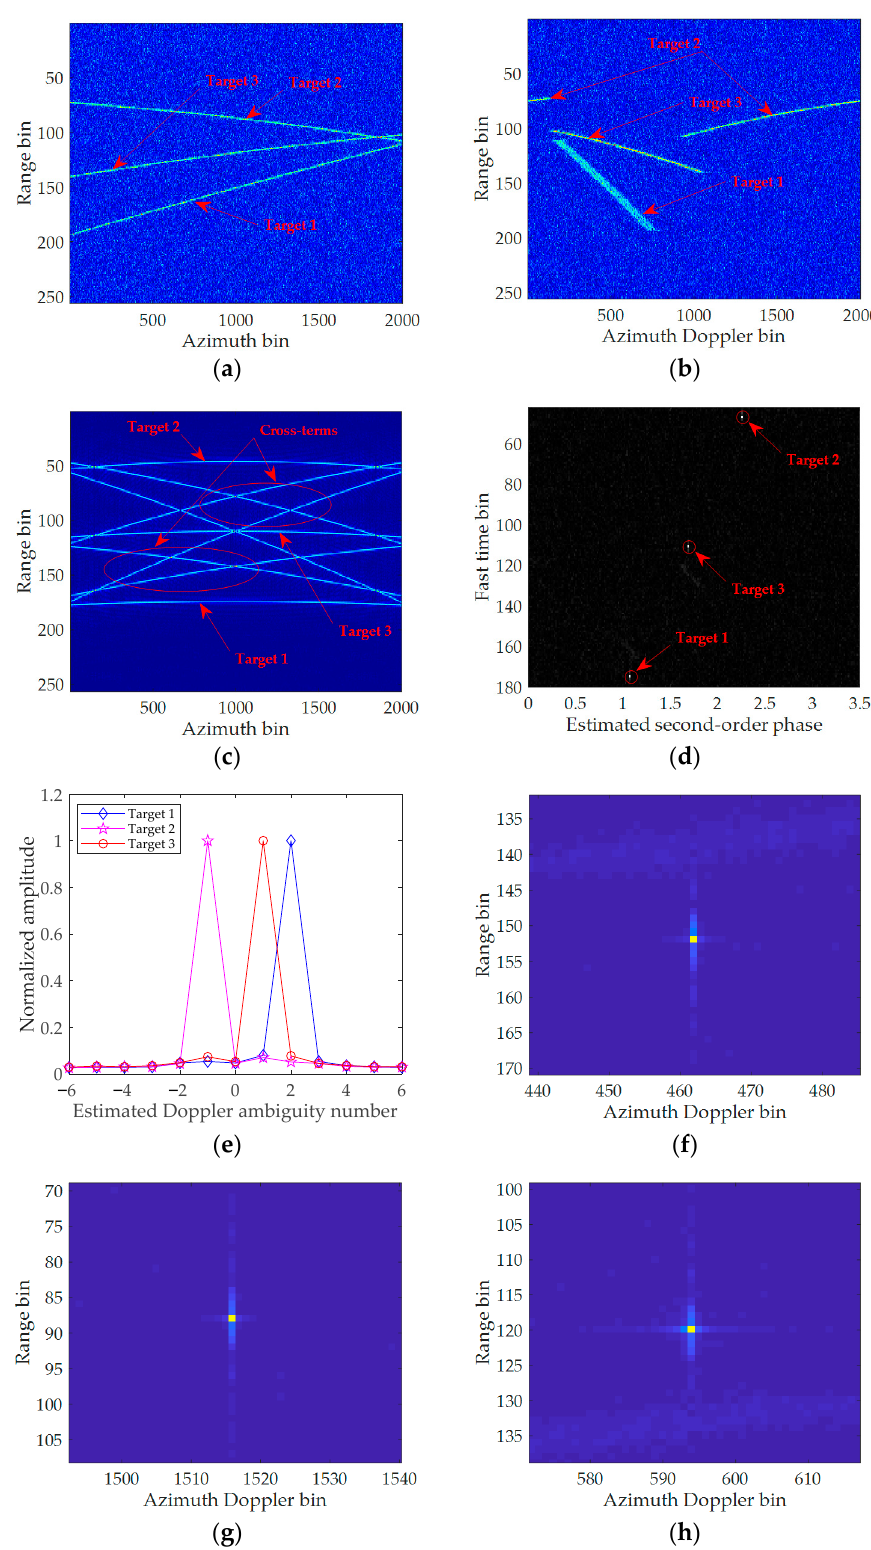
Figure 5. Simulation Experimental Results: ( a ) Result of range compression of three targets. ( b ) Azimuth spectrum distributions of three targets. ( c ) Result of parameter separation operation in Equation (10) of three targets. ( d ) MSOKT result of three targets. ( e ) Estimated results of Doppler ambiguity number of three targets. ( f ) Final refocused result of Target 1. ( g ) Final refocused result of Target 2. ( h ) Final refocused result of Target 3.